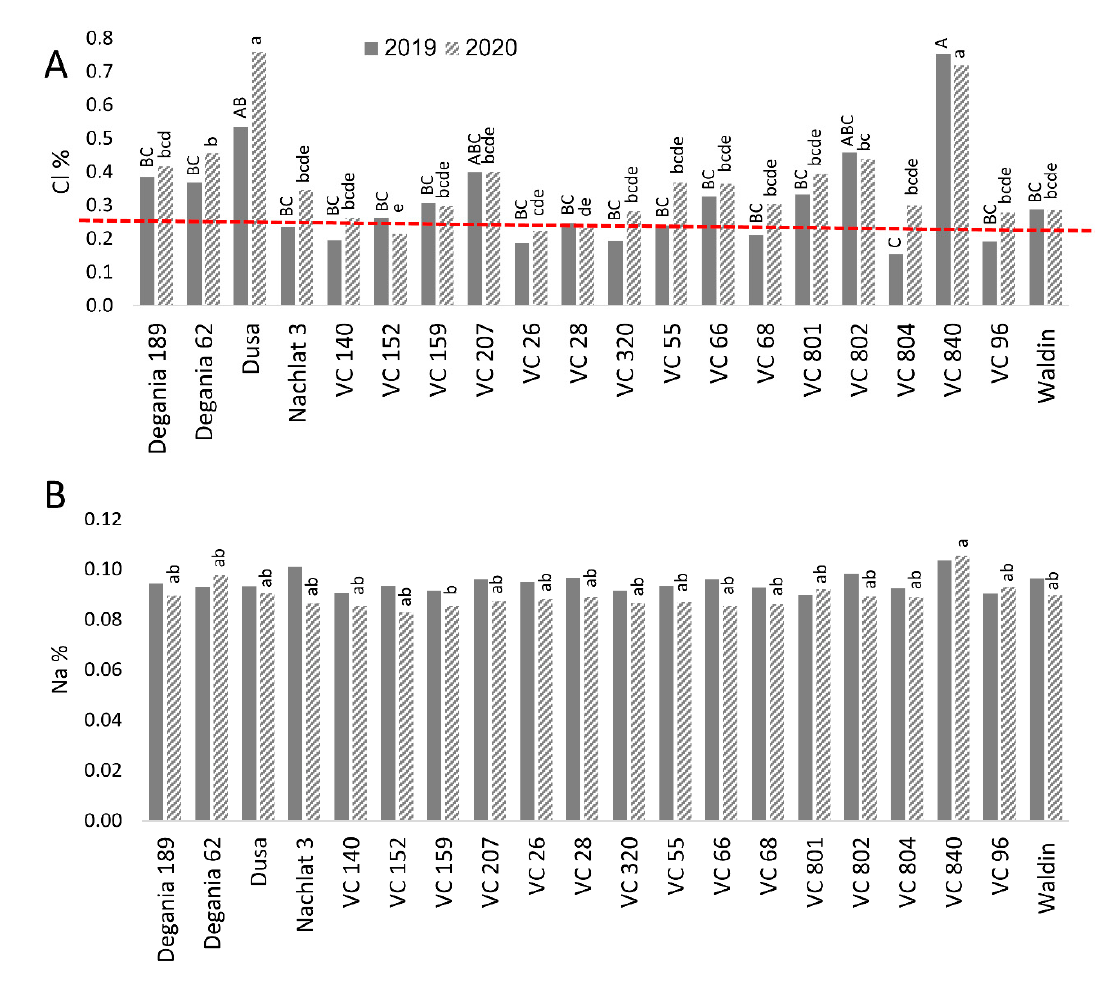
Figure 1. Salt content in leaves of ‘Hass’ avocado trees grafted onto various rootstocks. ( A ): chlorides. ( B ): sodium. Different letters (upper case for 2019 and lower case for 2020) represent significant ( p ≤ 0.05) differences between rootstocks. The dashed line represents the avocado leaf Cl upper standard suggested by the University of California, above which is considered harmful to the trees. SD values are presented in Table S1.